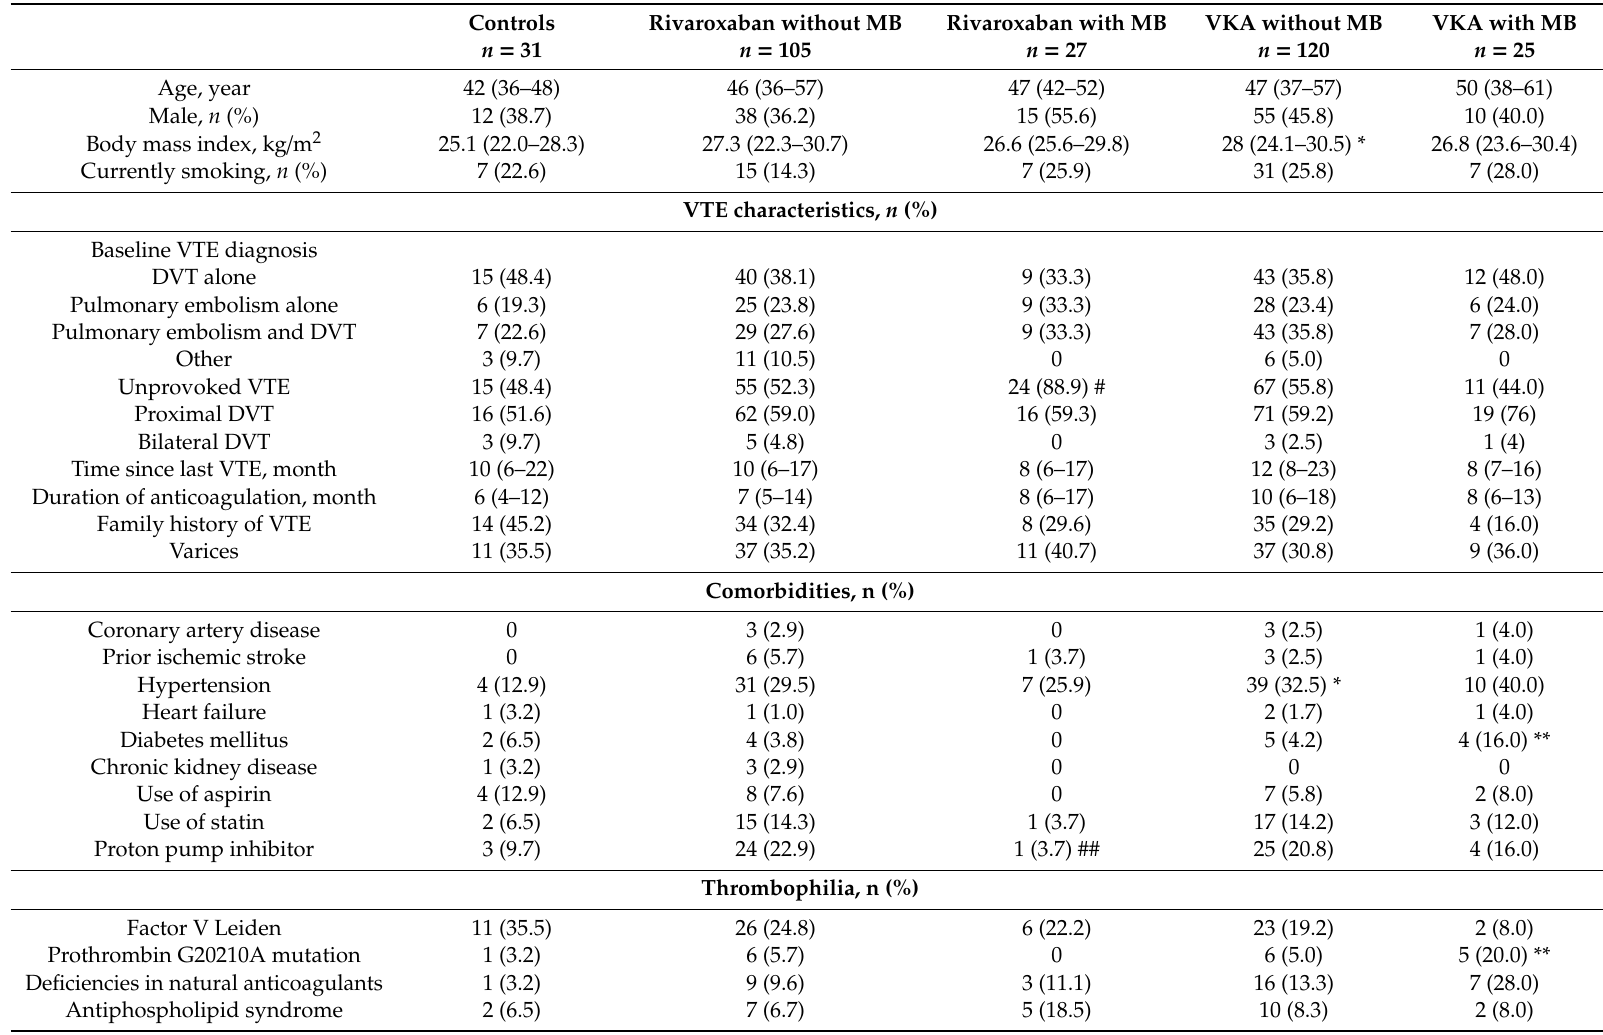
Table 1. Baseline characteristics of the studied